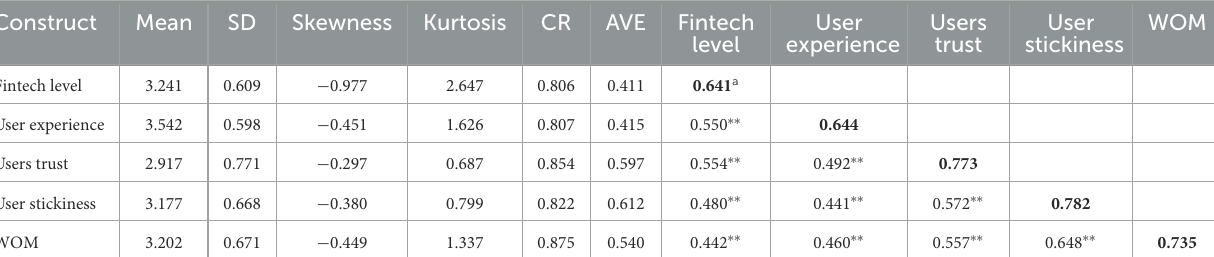
TABLE 4 Confirmatory factor analysis (b).